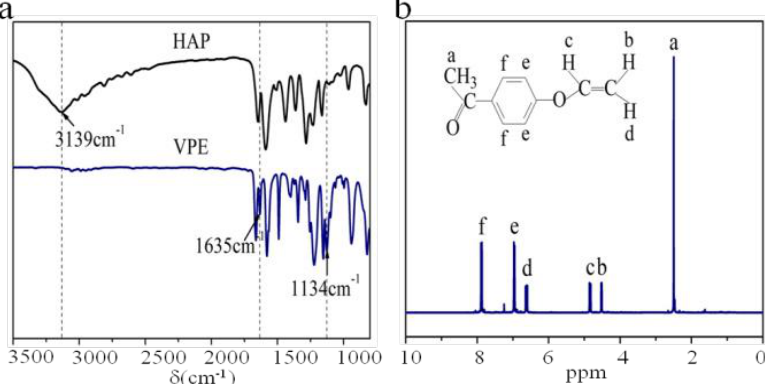
Figure 1. FTIR and 1 H NMR analysis. ( a ) FTIR spectra of HAP and VPE; ( b ) 1 H NMR spectra of VPE.